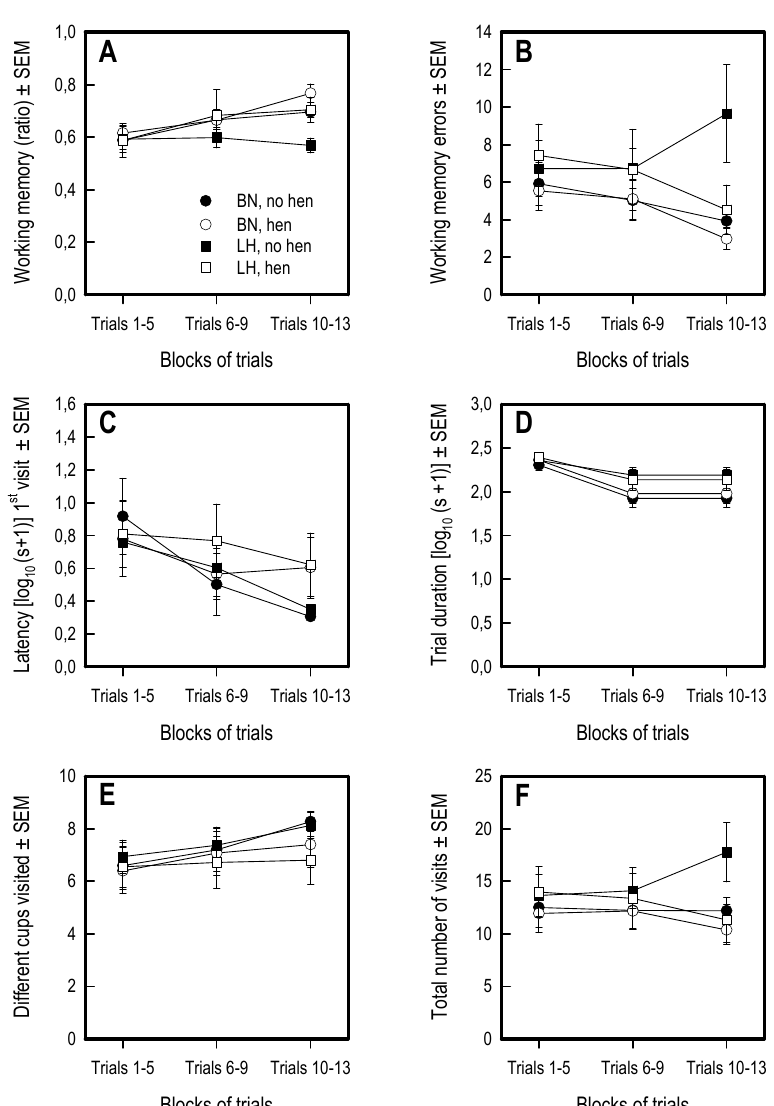
Figure 6. Relevant behavioral measures in the holeboard spatial working memory task. ( A ) Working memory ratio, ( B ) Working memory errors, ( C ) Latency to visit first cup (log values), ( D ) Trial duration (log values), ( E ) Di ff erent cups visited, ( F ) Total number of visits to cups (see Table 1 for complete explanation of variables). A trend to e ff ect of genetic strain was found on working memory. A significant e ff ect of session was found on working memory (ratio), latency to first visit, trial duration and di ff erent cups visited. No other main e ff ects or interactions were observed. Lines represent averages and